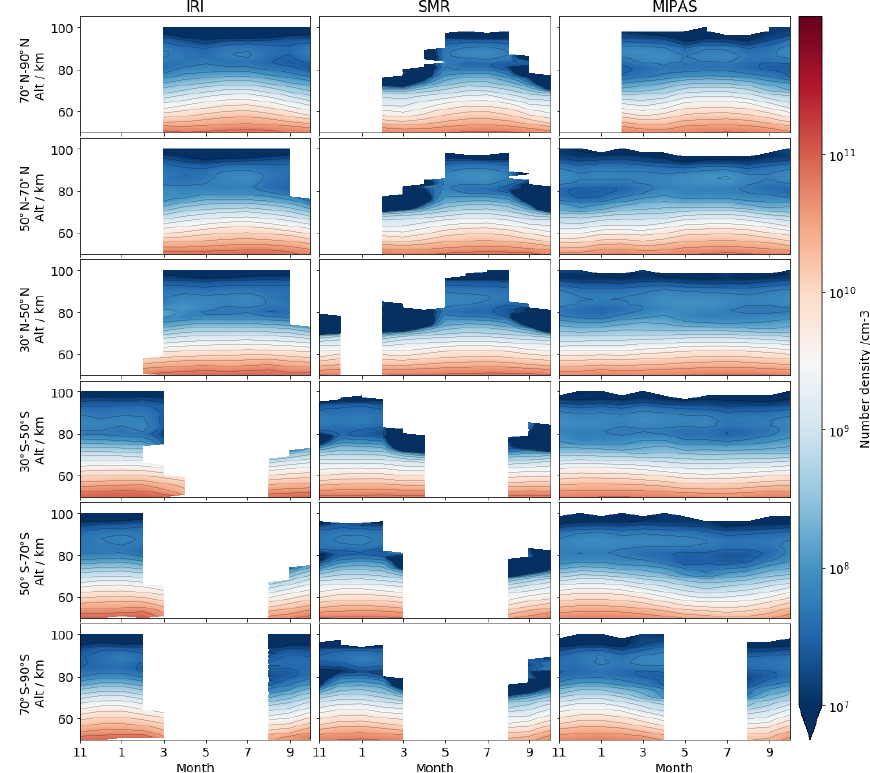
Figure 12. Monthly mean daytime ozone number density from November 2007 to October 2008 in six selected latitude bands (in rows). Columns from the left to right represent IRI, SMR and MIPAS,